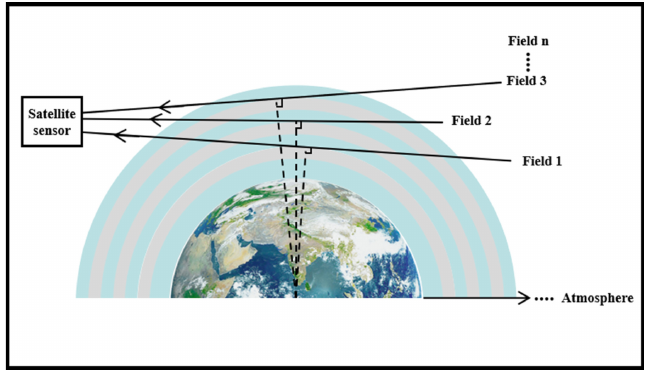
Figure 1. Schematic diagram of limb-scan